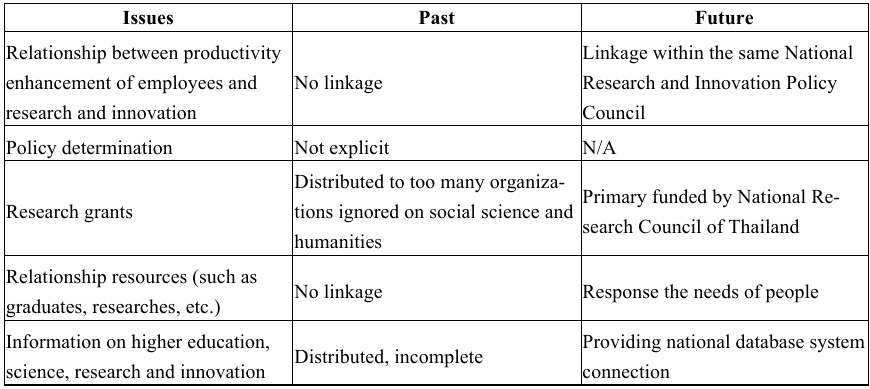
Table 1. Issues toward challenges and trends in